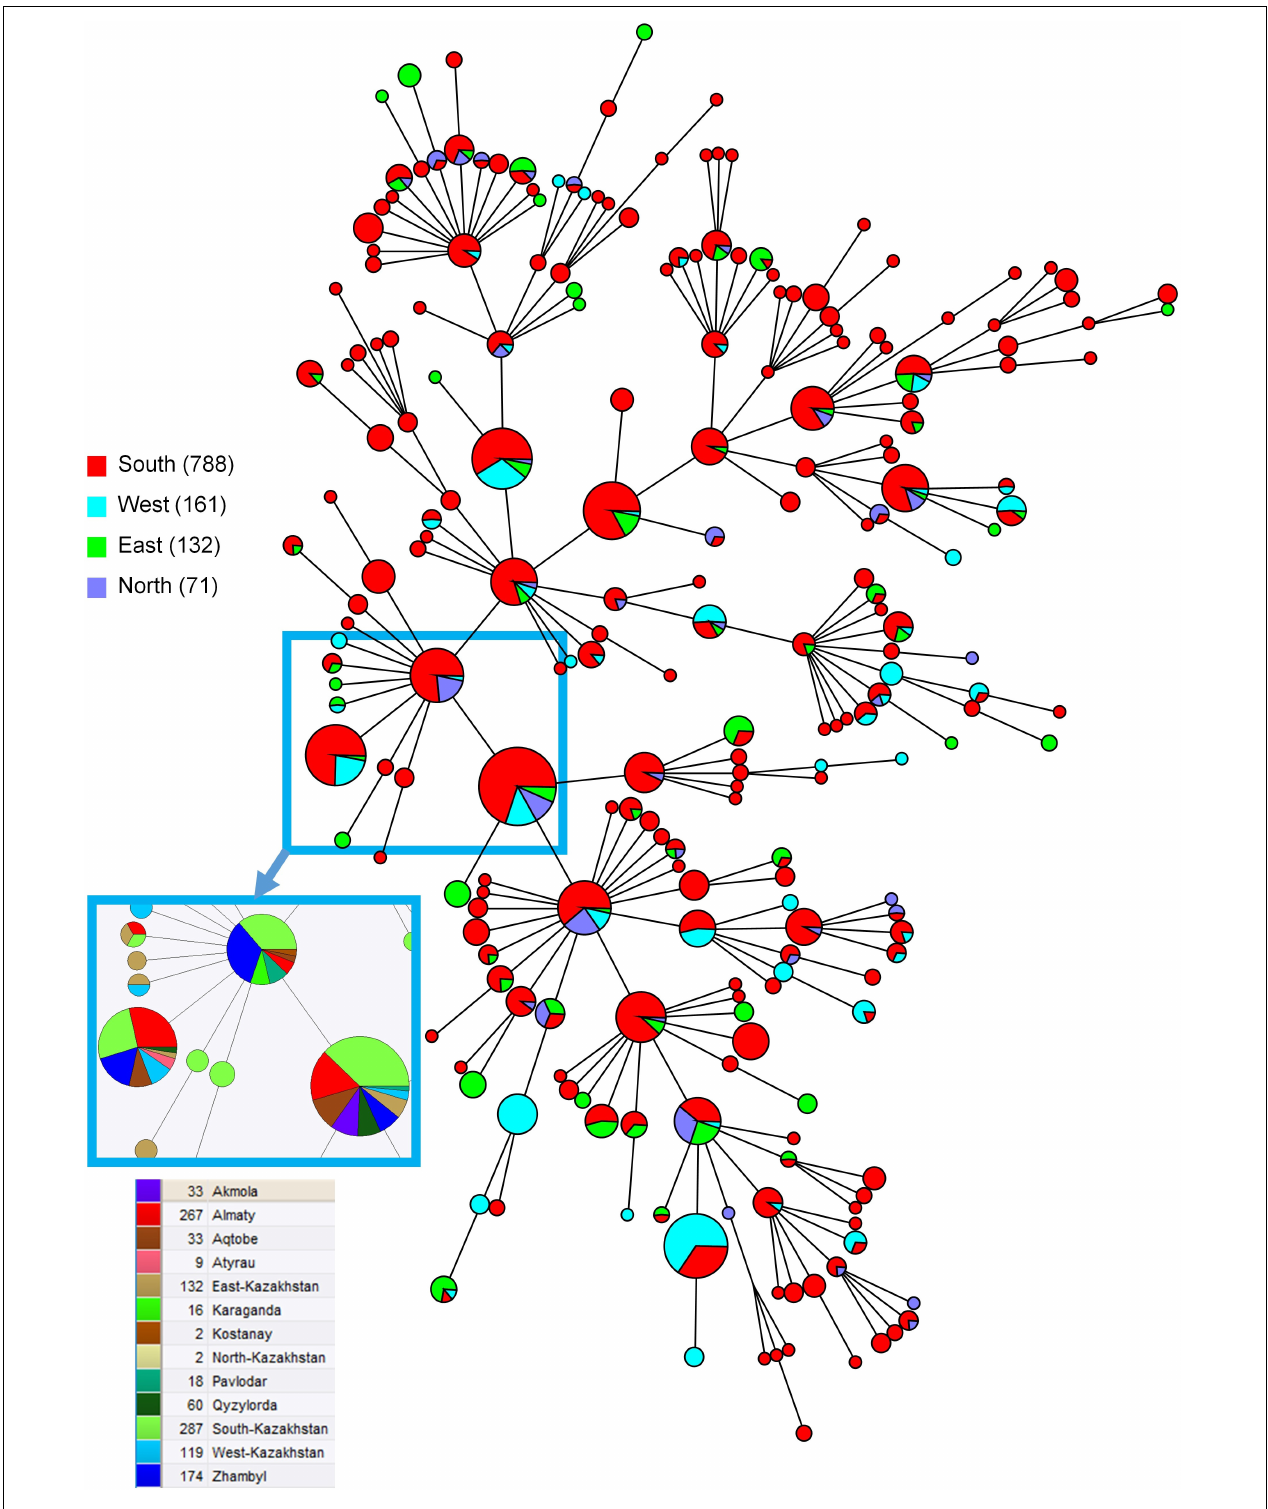
FIGURE 4 | Maximum parsimony analysis using MLVA16 for 1152 genotype 116 B. melitensis strains isolated from humans in Kazakhstan. The color code reflect the geographic origin of the strains (South: Almaty, Qyzylorda, Zhambyl, South-Kazakhstan; West: Aqtobe, Atyrau, West Kazakhstan; East: East Kazakhstan; North: Akmola, Kostanay, Karaganda, Pavlodar, North Kazakhstan). Inset: color code by region for a subset of the most frequent MLVA16 genotypes showing their wide geographic spreading. Branch lengths correspond to one up to two differences among the 16 values constituting the MLVA16 genotype.